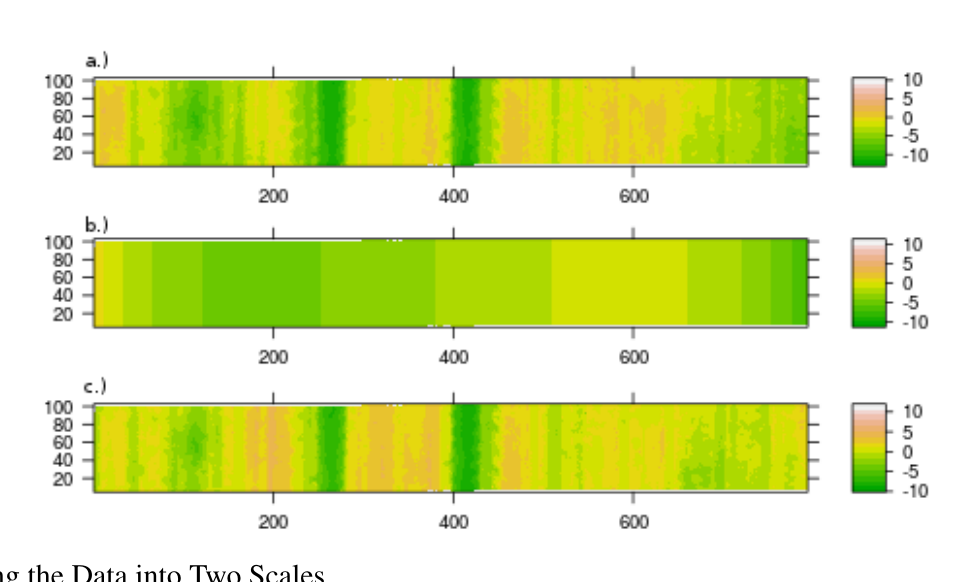
Figure 6. Results of detrending sample plot R13 with ( a ) original surface, ( b ) fitted trend surface using polynomial approach and ( c ) residual surface preserving row structure. Units in